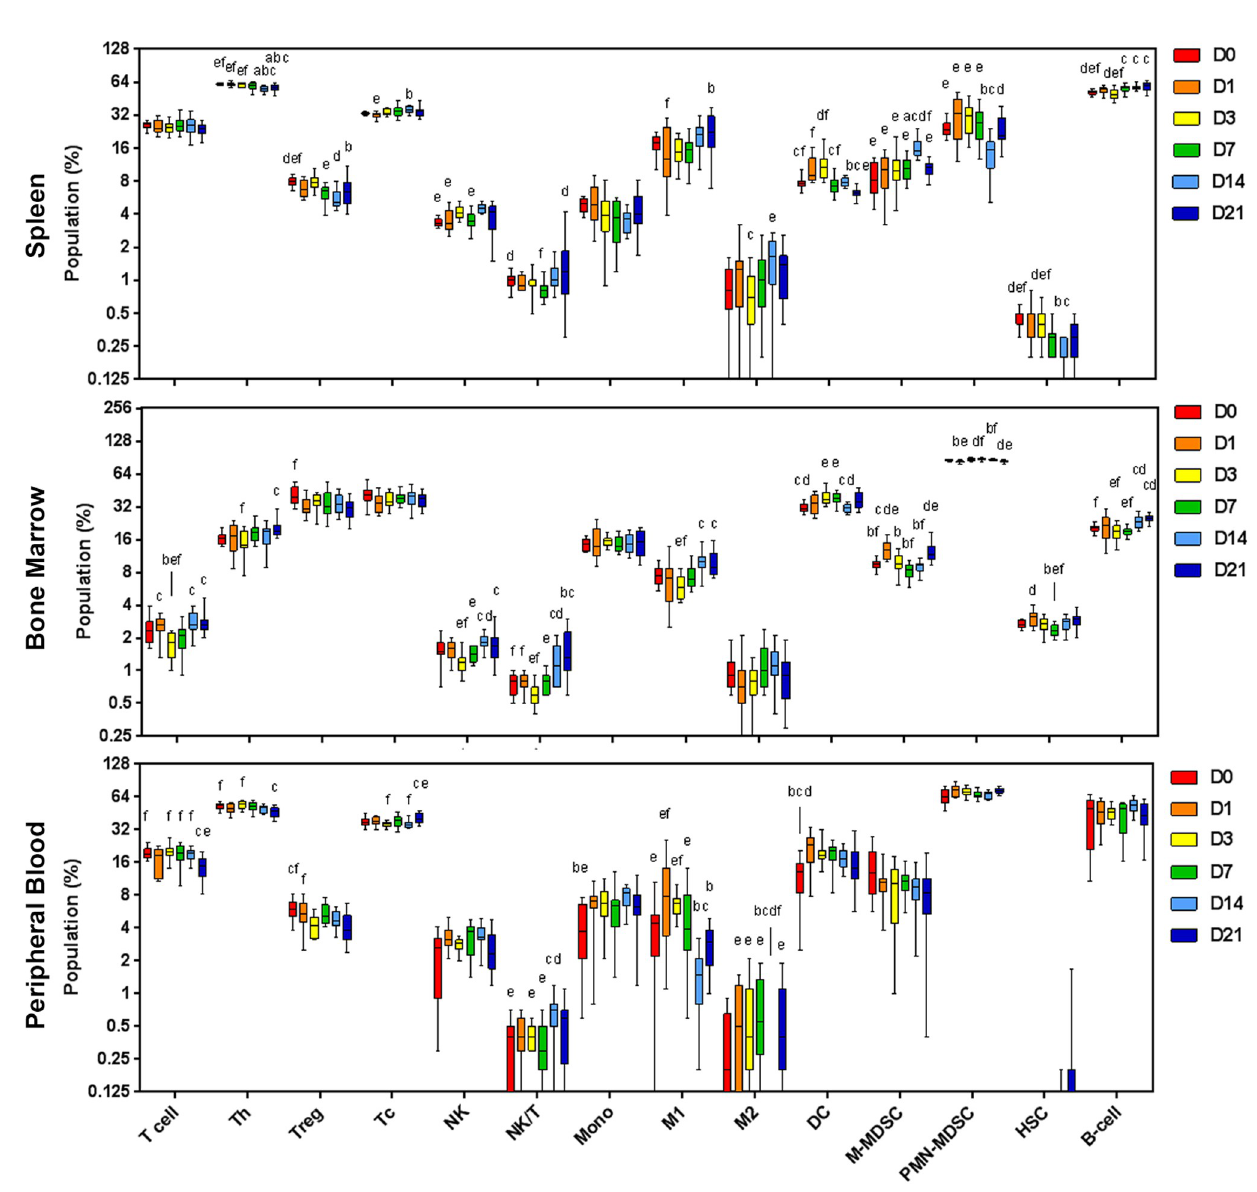
Fig 6. Systemic immune cell populations. Immune cell populations from spleen, bone marrow and peripheral blood from mice inoculated with glioma Gl261 cells. Cells were harvested at day 0 (sham) to day 21 time points and assessed by multi-color flow cytometry. Data are expressed as percentage of parent population (%). a p < 0.05 vs D0, b p < 0.05 vs D1, c p < 0.05 vs D3, d p < 0.05 vs D7; e p < 0.05 vs D14; f p < 0.05 vs D21 by Dunn’s Multiple Comparison